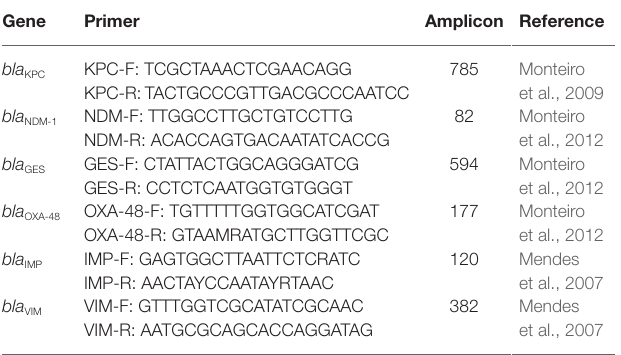
TABLE 1 | Primers and probes used in multiplex PCR